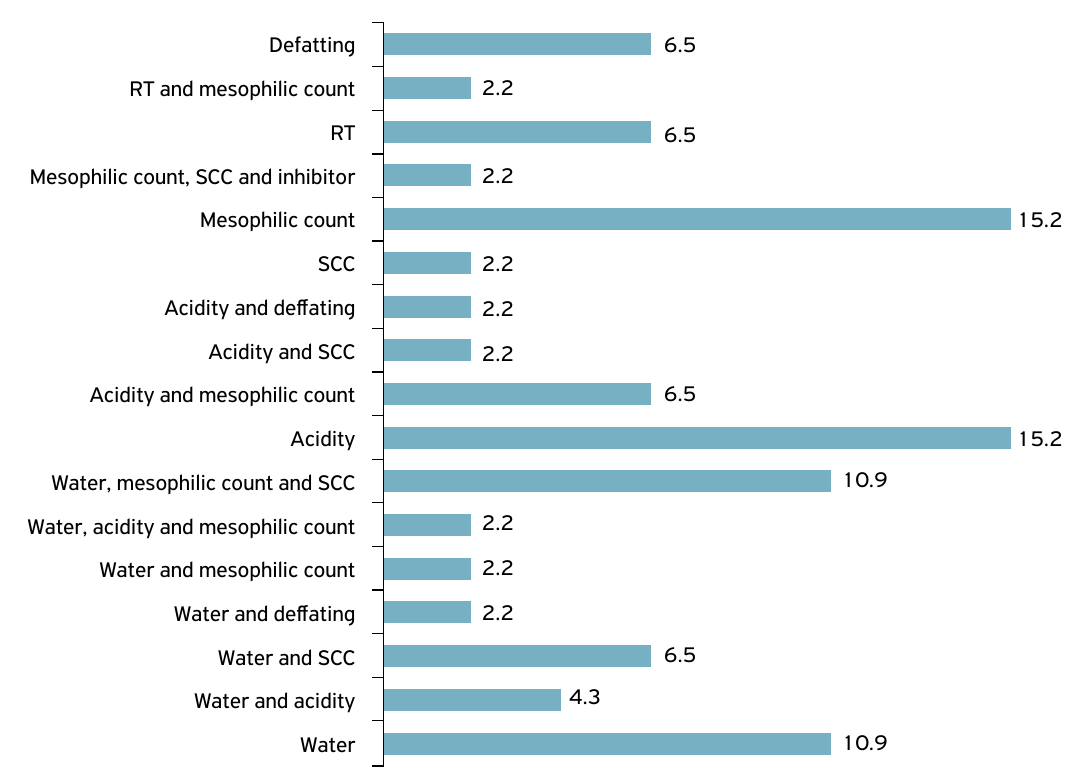
Figure 1. Inference on the status of all samples of uninspected raw milk analyzed (n = 46), based on the overall interpretation of the laboratory assays